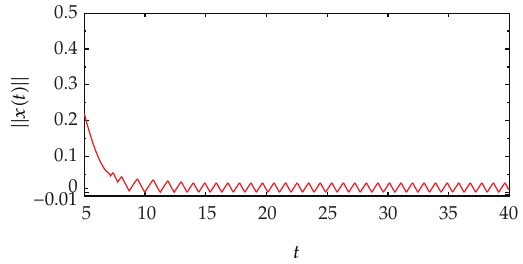
Figure 6: (cid:8) x (cid:2) t (cid:3) (cid:8) of PWM feedback system (cid:2) 3.6 (cid:3) in Example